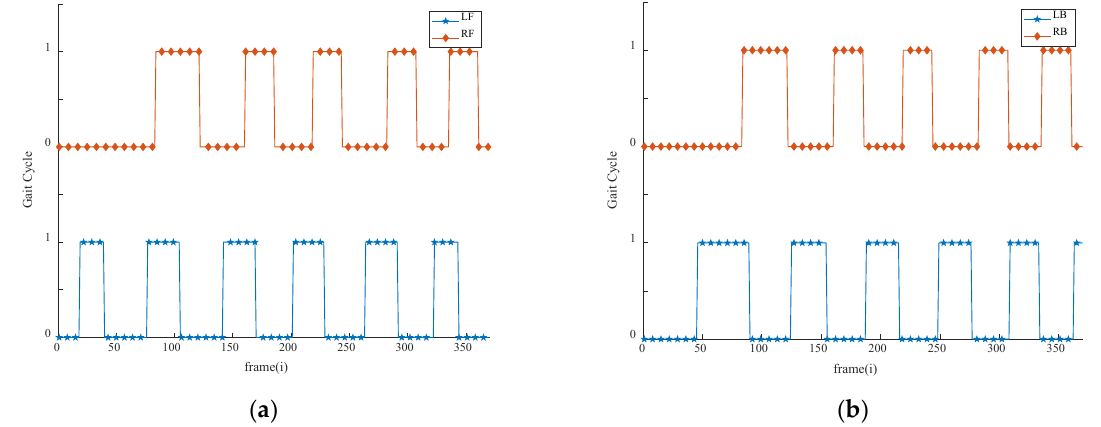
Figure 19. ( a ) Horse’s gait cycle of LF, RF leg; ( b ) horse’s gait cycle of LB, RB leg.